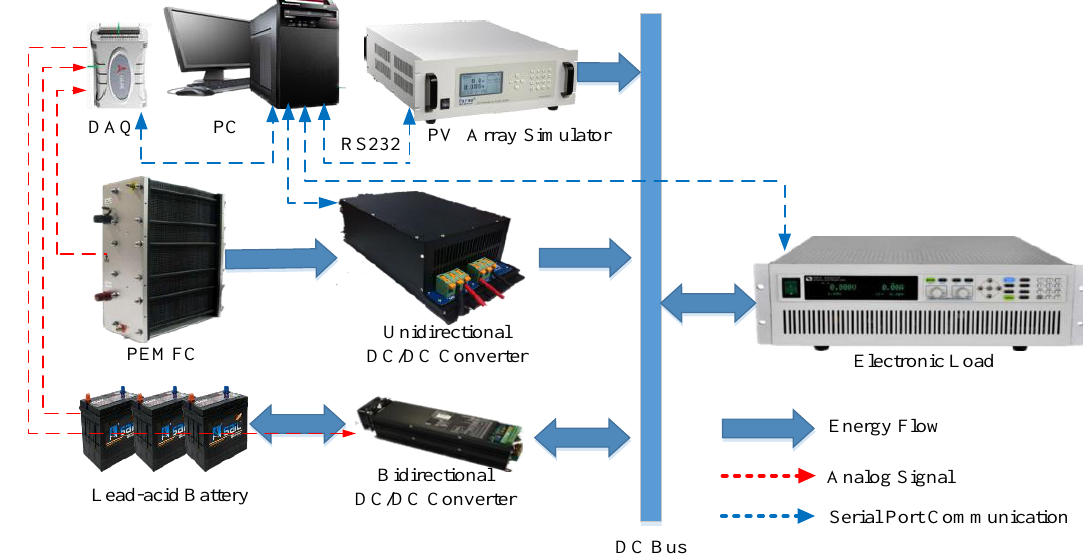
Figure 1. Configuration of the proposed DC microgrid. Table 1. Parameters of the proposed DC microgrid.